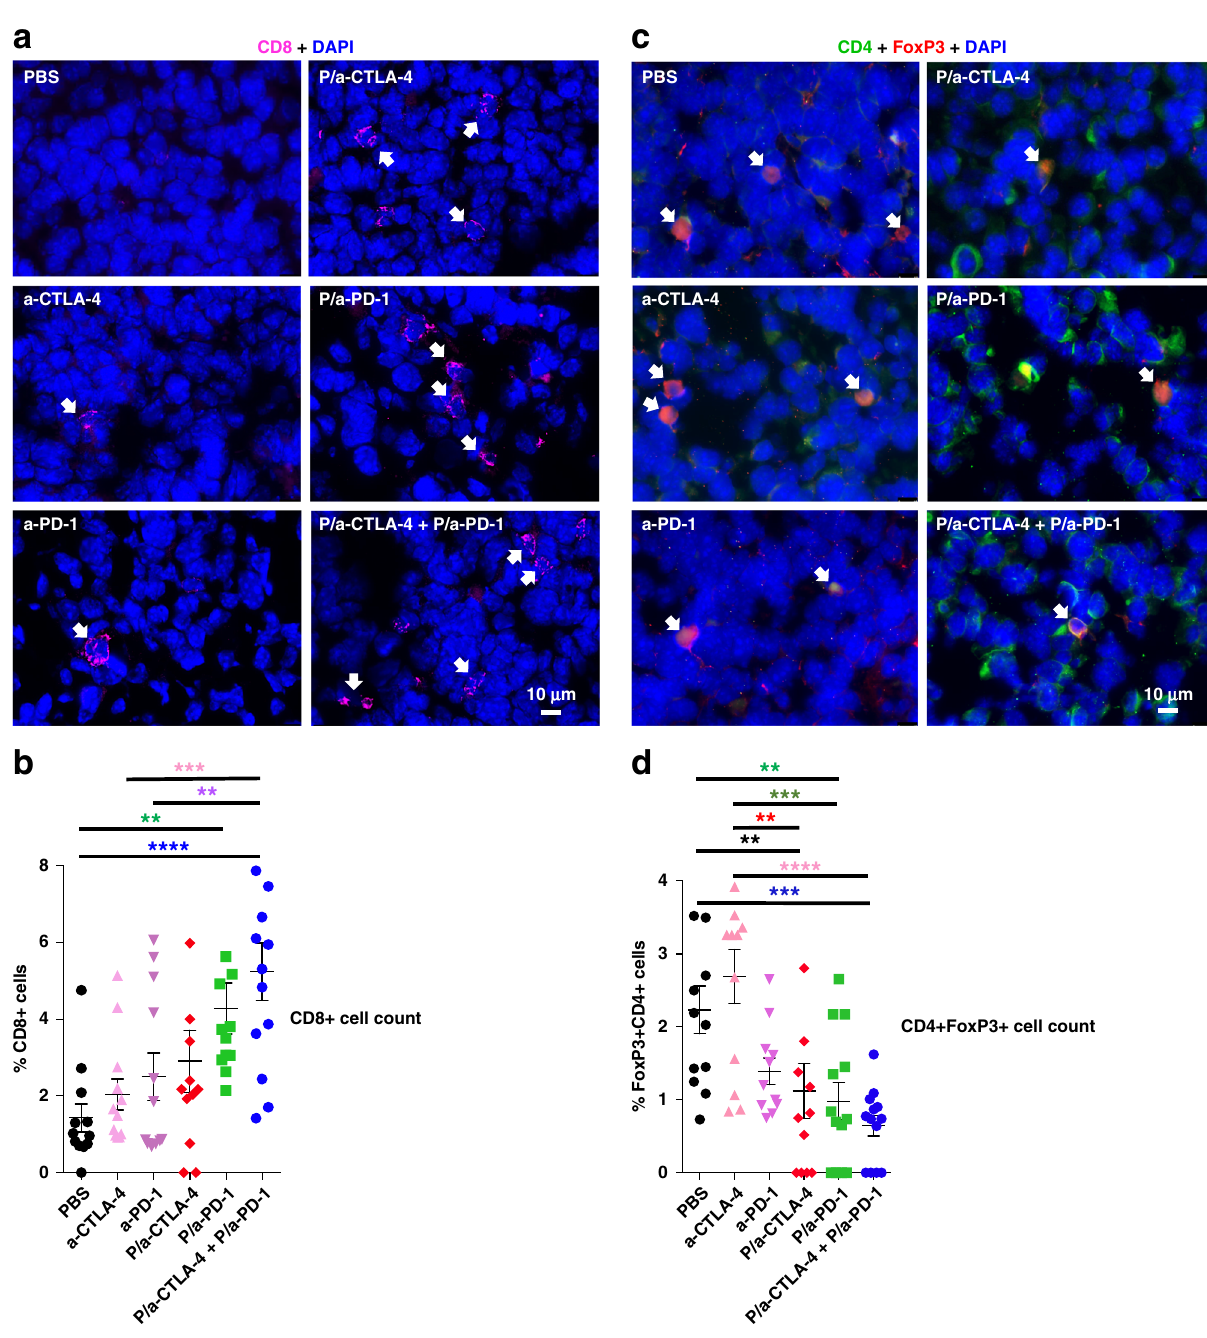
Fig. 4 CD8 + increase and CD4 + FoxP3 + decrease in glioma after NIC treatment. a Immunostaining of CD8 + T cells in tumors treated with PBS, a-CTLA- 4, a-PD-1, P/a-CTLA-4, P/a-PD-1, and P/a-CTLA-4 + P/a-PD-1. Arrows indicate CD8 + lymphocytes (magenta) that increase after NIC treatment. Scale bar on bottom right panel applies to all other images. b Treatments with P/a-PD-1 and P/a-CTLA-4 + P/a-PD-1 result in a statistically signi fi cant increase of CD8 + lymphocytes inside the tumor. 8499 cells are analyzed in tumors from 24 mice representing six treatment groups, N = 4 per group. Data are mean ± SEM. ** p < 0.01; *** p < 0.001; **** p < 0.0001 (one-way ANOVA with Sidak ’ s posttest). c Immunostaining of CD4 + FoxP3 + T cells in tumors treated with PBS, a-CTLA-4, a-PD-1, P/a-CTLA-4, P/a-PD-1, and P/a-CTLA-4 + P/a-PD-1. Arrows indicate CD4 + FoxP3 + lymphocytes that are decreased after NIC treatment. CD4 staining is green, FoxP3 staining is red, DAPI nuclear staining is blue. d P/a-PD-1 and P/a-CTLA-4 + P/a-PD-1 treatments signi fi cantly decrease the number of CD4 + FoxP3 + lymphocytes in the tumor. 9898 cells are analyzed in tumors from 24 mice representing six treatment groups, N = 4 per group. ** p < 0.01; *** p < 0.001; **** p < 0.0001 (one-way ANOVA with Sidak ’ s NICs increase systemic immune response . When activated, levels for multiple interleukins vs. PBS (Supplementary Fig. 6). CD4 + and CD8 + T cells produce in fl ammatory cytokines. To However, NIC combination produced signi fi cant increases of examine whether NIC treatment elicited systemic immune acti- most cytokines vs. PBS treatment (Supplementary Fig. 6A-I): IL- vation, serum cytokine levels were measured by multiplex assay. Treatment with single NICs showed a slight increase of serum